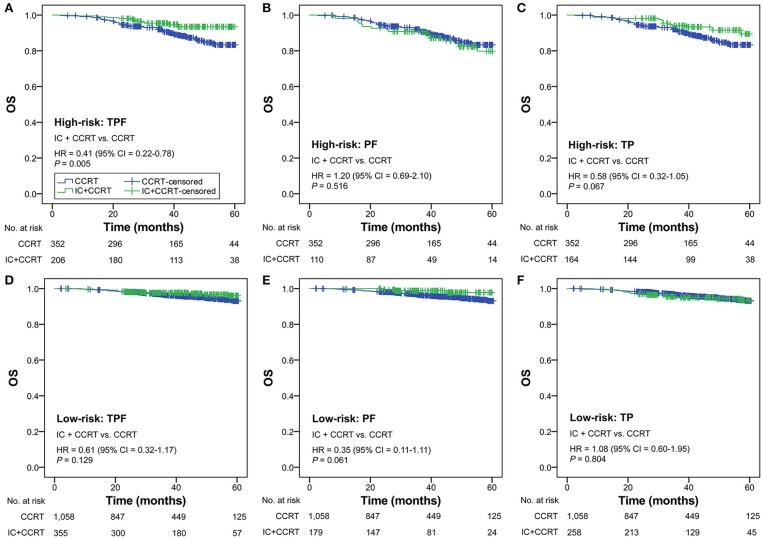
IC+CCRT vs. CCRT in the subgroup analysis based on IC regimen [high-risk: TPF (A), PF (B), TP (C); low-risk: TPF (D), PF (E), TP (F)] without adjustment. IC, induction chemotherapy; CCRT, concurrent chemoradiotherapy; TPF, docetaxel–cisplatin−5-fluorouracil; PF, cisplatin−5-fluorouracil; TP, cisplatin−5-fluorouracil.